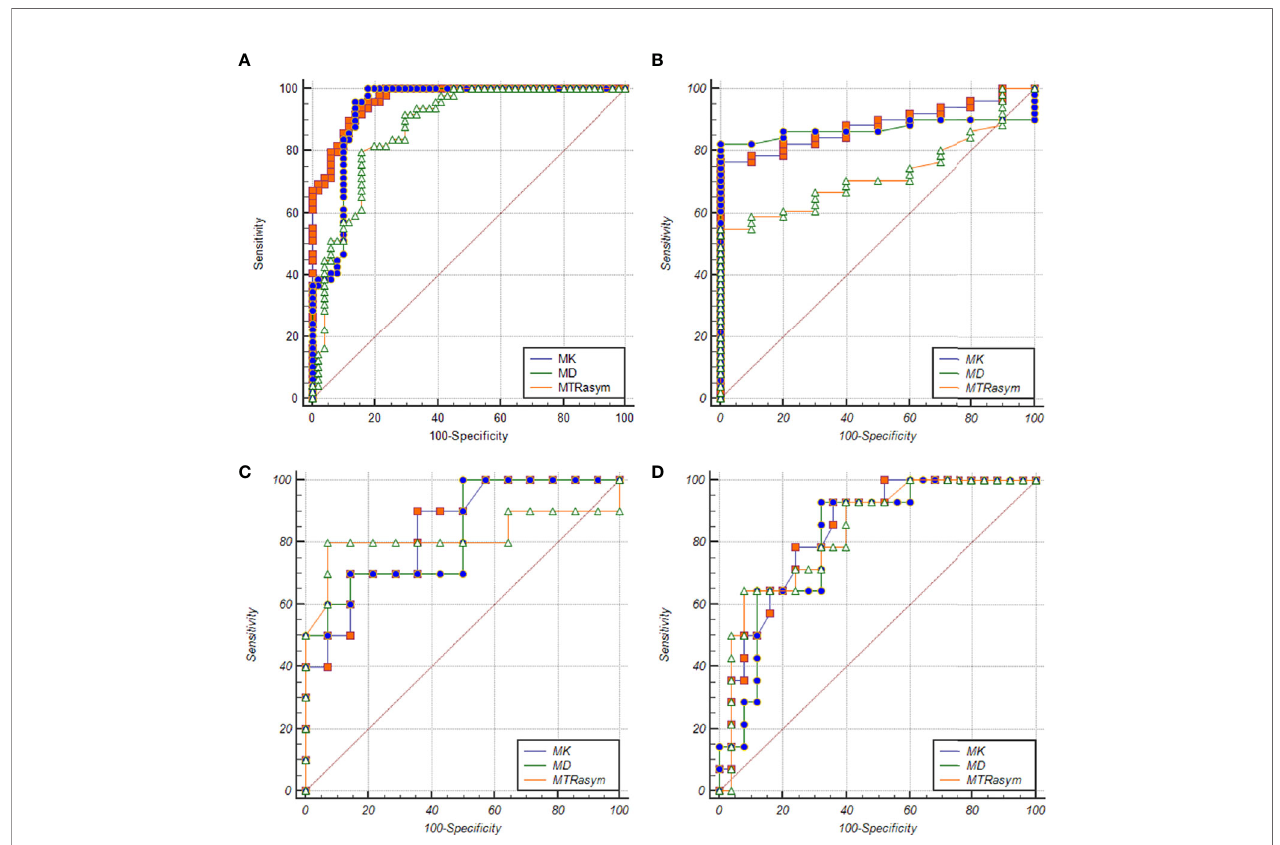
FIGURE 5 | ROC curves of MK/MD/MTRasym (3.5 ppm) values between BPH and PCa groups (A) , BPH and low-risk groups (B) , low-risk and intermediate-risk groups (C) , intermediate-risk and high-risk groups (D) , respectively.